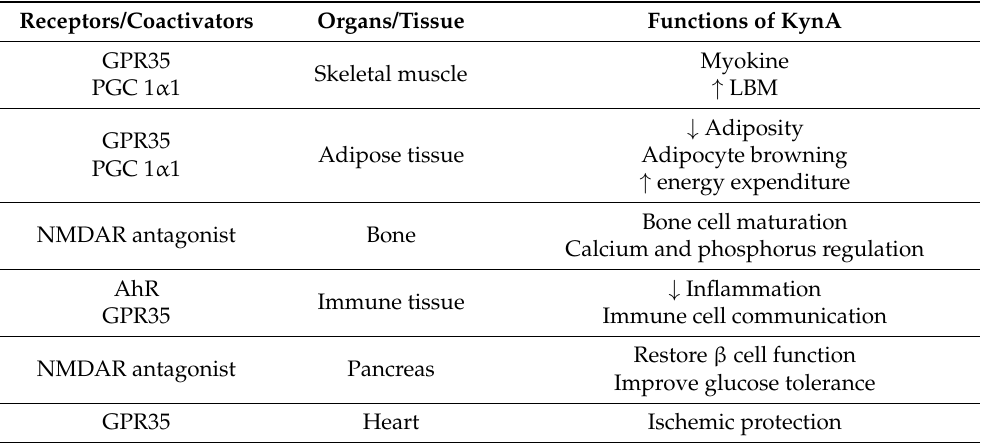
Table 1. Potential biological activities of circulating kynurenic acid in peripheral